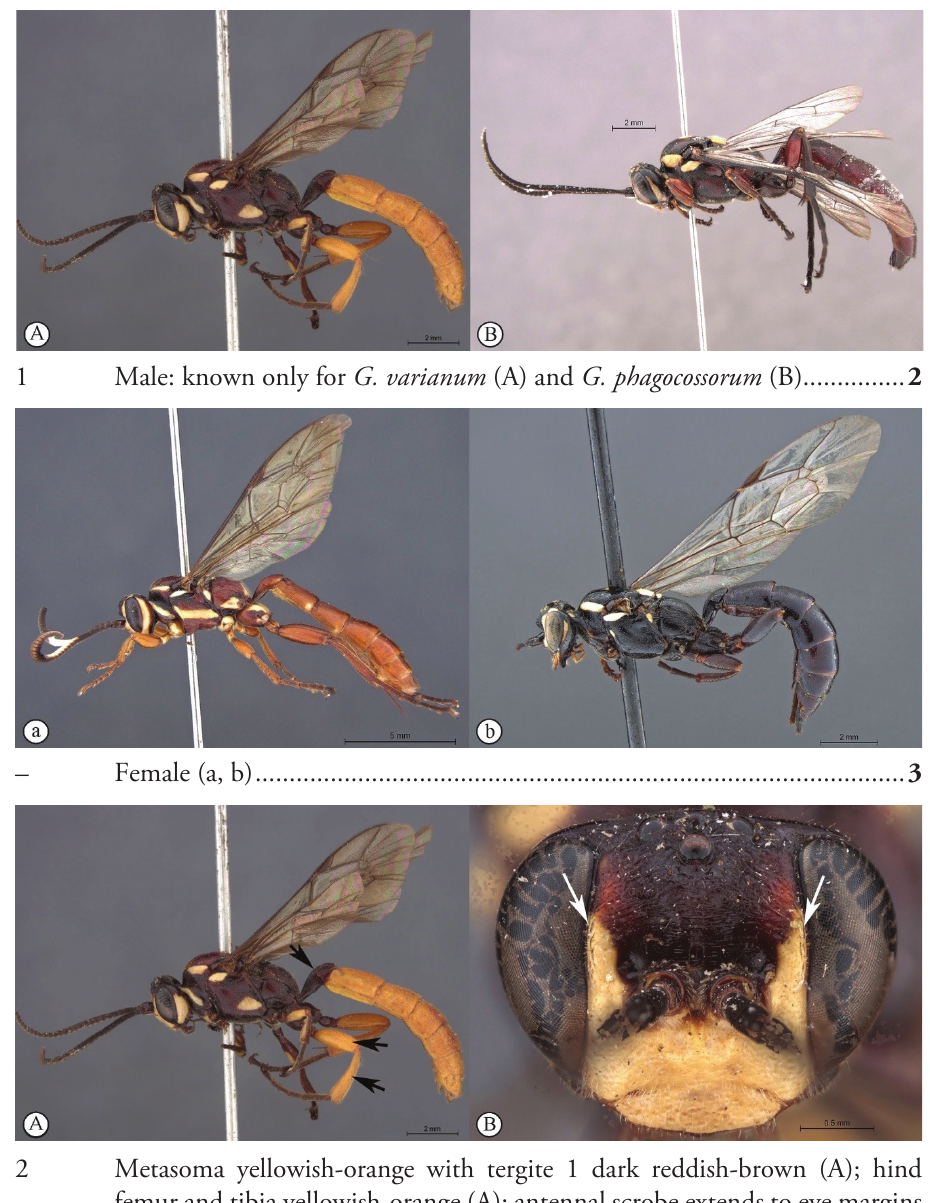
Metasoma yellowish-orange with tergite 1 dark reddish-brown (A); hind femur and tibia yellowish-orange (A); antennal scrobe extends to eye